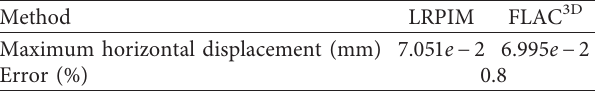
Table 2: Horizontal displacement comparison. Method